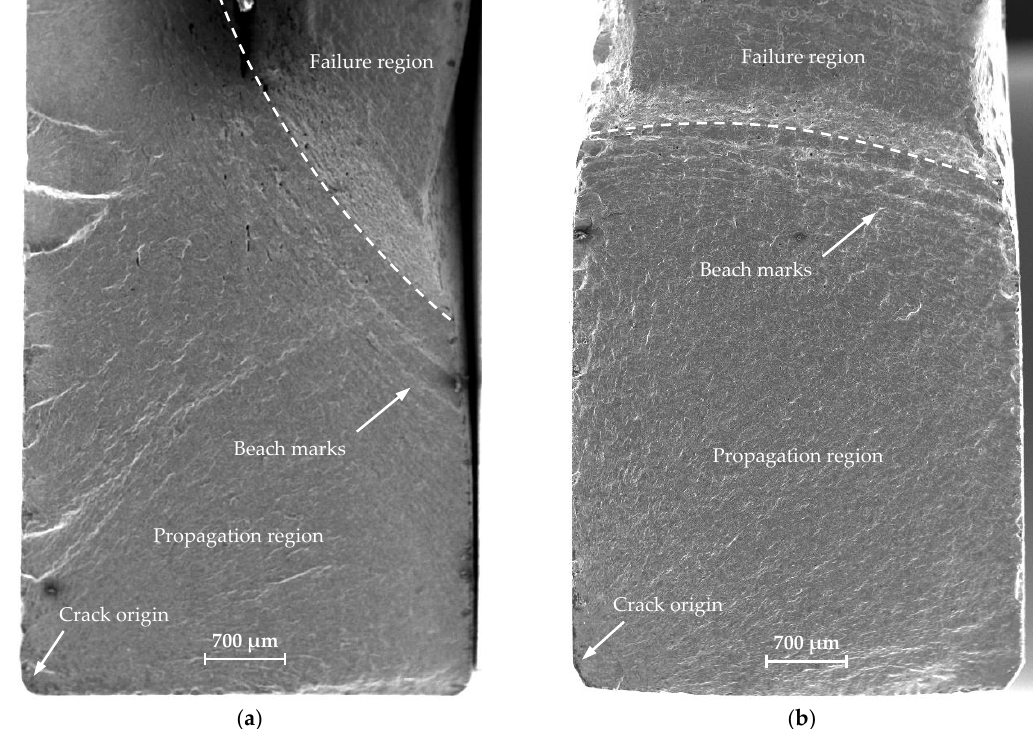
Figure 12. Overall fracture surfaces of standard specimen: ( a ) S235JR steel; ( b ) 1.4301 steel.